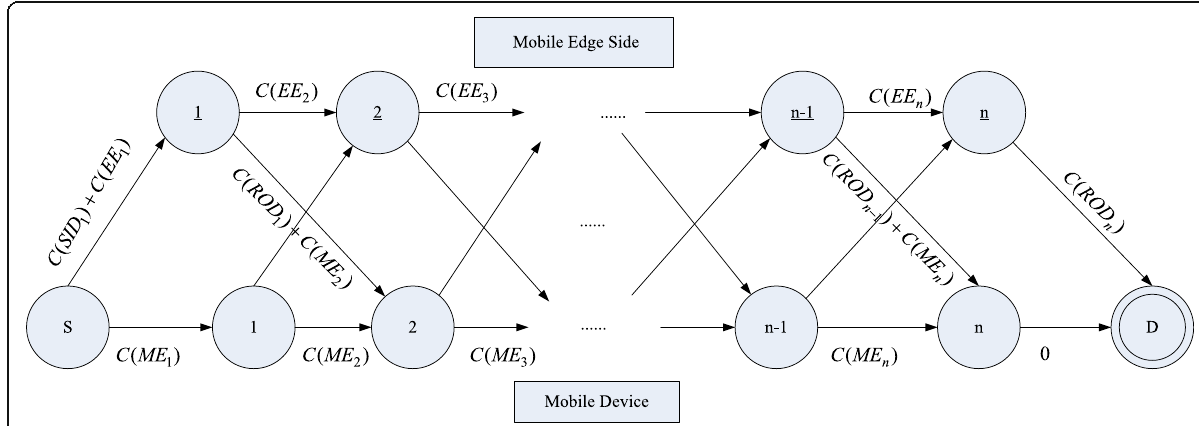
Fig. 3 Fine-grained linear task execution flow. It is a simple fine-grained linear task topology diagram. It considers that each subtask is either executed on the mobile terminal side or executed on the mobile edge side, and the calculated energy consumption generated when the task is performed on the mobile terminal side is denoted as C ( ME ), and the energy consumption generated when the task is performed on the mobile edge side is denoted as C ( EE ). Send energy consumption is C ( SID ), and receive energy consumption is C ( ROD